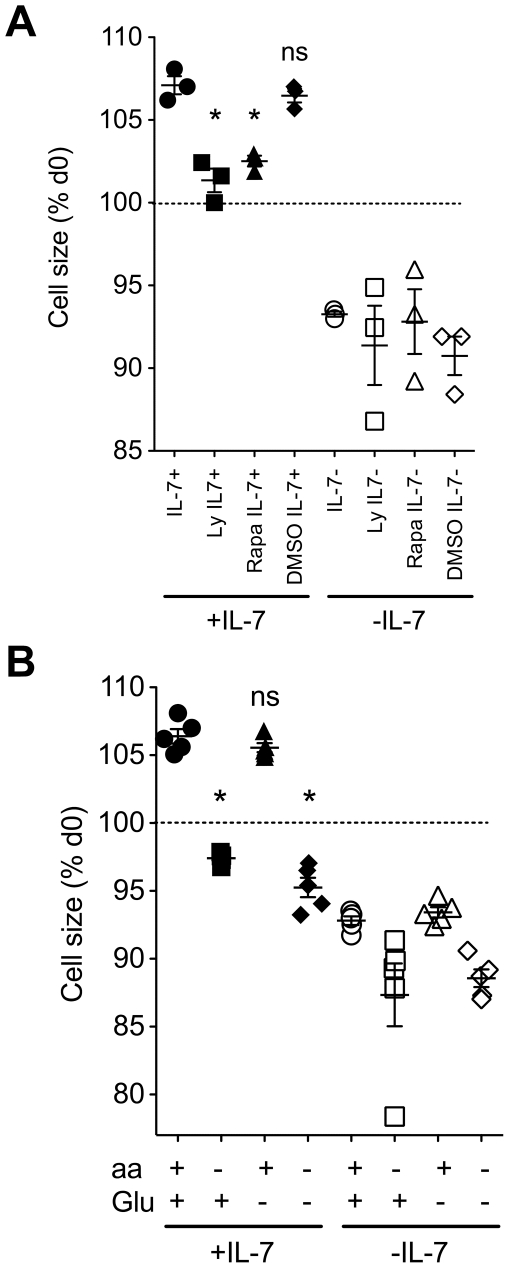
IL-7 induced T cell growth is strictly dependent on exogenous amino acids but not glucose.CD8+ T cells were enriched from C57B6/J donors and cultured for 3 days in RPMI containing standard nutrients, either alone (open symbols), or in the presence of 50 ng/ml IL-7 (filled symbols). Cultured cells were stained with 7AAD and size of viable CD44lo CD8+ T 7AAD− cells determined by measuring FSc by FACS. (A) Where indicated, the inhibitors LY294002 (Ly, squares) (10 µM), rapamycin (Rap, triangles) (20 nM) or the vehicle control (DMSO, diamonds) were added to cultures. (B) Cells were cultured in RPMI medium containing standard nutrients (circles) or in RPMI specifically lacking amino acids (squares), glucose (triangles) or lacking both glucose and amino acids (diamonds). Cells were cultured in the presence (filled symbols) or absence (empty symbols) of exogenous IL-7 (50 ng/ml). Results are the pool of three or more independent experiments. Each point plotted is the mean of triplicate cultures for a single independent experiment. Error bars indicate SD of biological replicates. * p<0.001; ns, not significant.